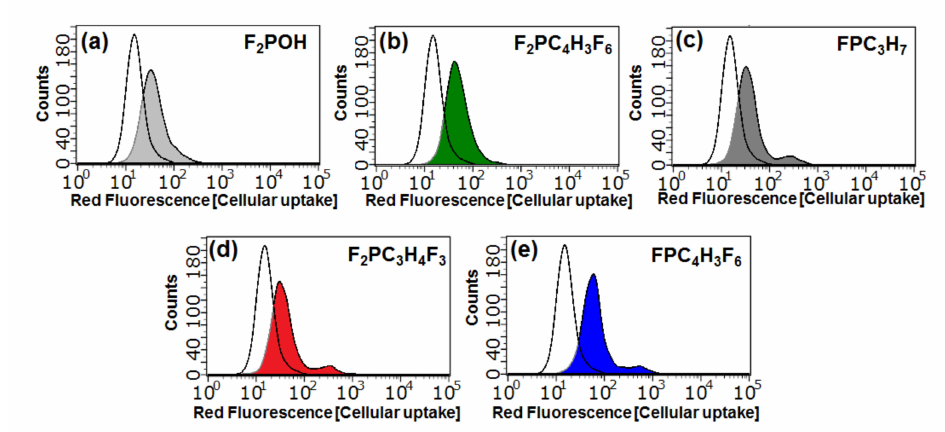
Figure 4. Cellular uptake determined in CT26 cells based on the red fluorescence of each porphyrin using flow cytometry. Histograms of the fluorescence intensities of the photosensitizer in CT26 (colored) or untreated cells (gray): ( a ) F 2 POH, ( b ) F 2 PC 4 H 3 F 6 , ( c ) FPC 3 H 7 , ( d ) F 2 PC 3 H 4 F 3 , ( e ) FPC 4 H 3 F 6 . The cells (0.5 × 10 6 cells / mL) were incubated with 20 µ M PS for 24 h, then washed twice with HBSS and analyzed with flow